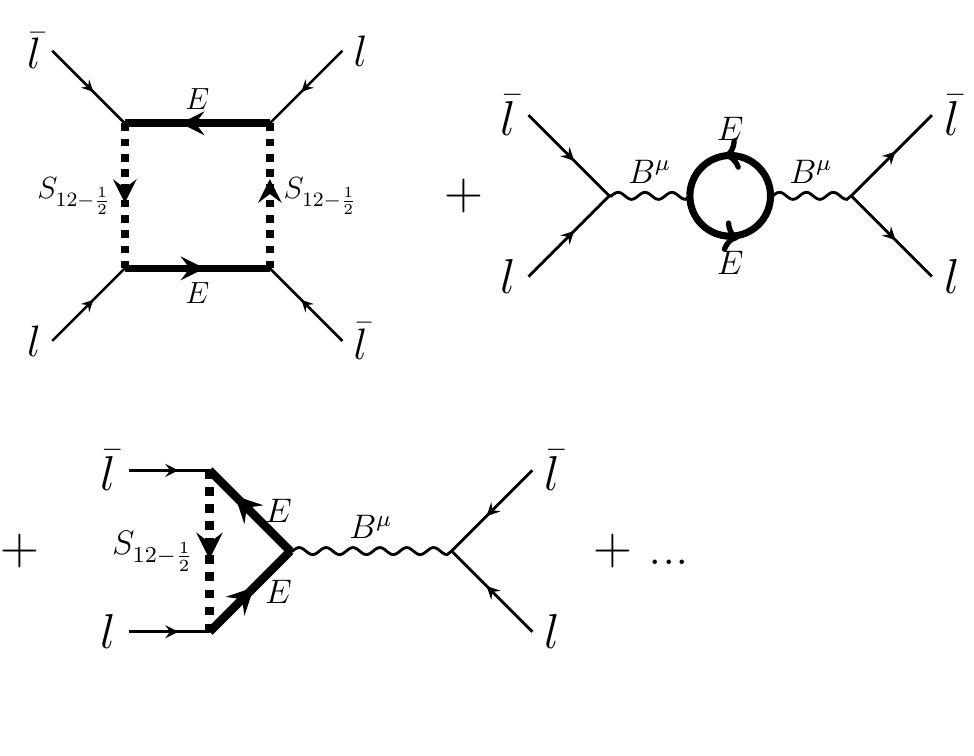
Figure 3. The figure illustrates how light particle reducible diagrams are generated, going from the complete Green’s basis to the on-shell Warsaw basis, see